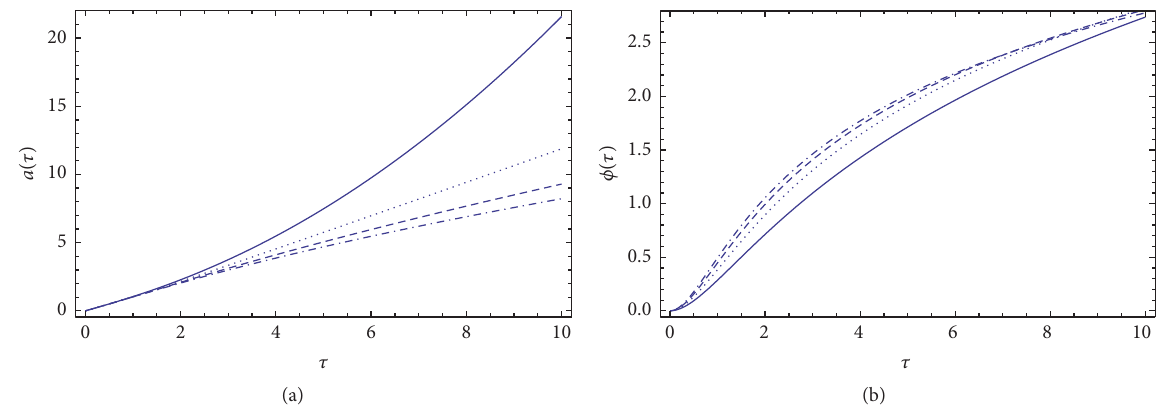
Figure 2: Variation of the scale factor of the Universe (a) and of the scalar field (b) as a function of the dimensionless time 𝜏 for the scalar field with exponential potential, for different values of the parameter 𝜆 : 𝜆 = −1 (solid curve), 𝜆 = −√2 (dotted curve), 𝜆 = −√3 (dashed curve), and 𝜆 = −2 (dashed dotted